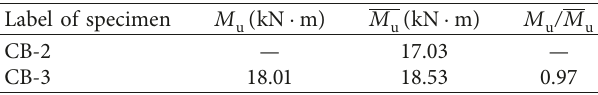
Table 14: Ultimate strength of CB-2 and CB-3.